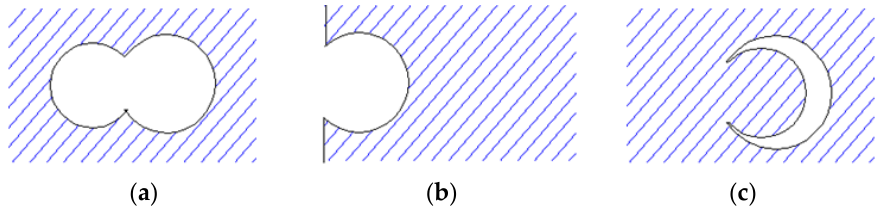
Figure 2. Possible forms of boundaries to be studied for β = ct : ( a ) β 1 < 0; β 2 > 0; ( b ) β 1 = 0; β 2 > 0; ( c ) β 1 > 0; β 2 > 0.